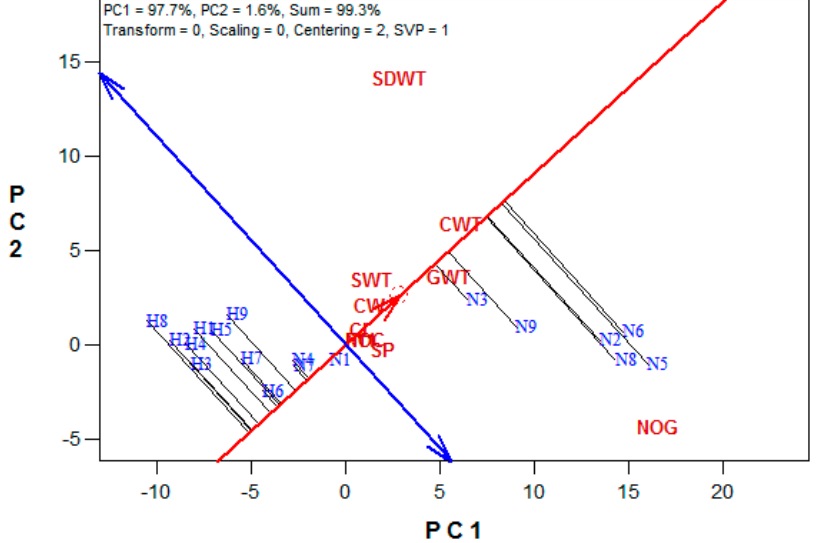
Figure 4. The mean performance vs. stability graph of the treatment interactions. (N1 = NHS–